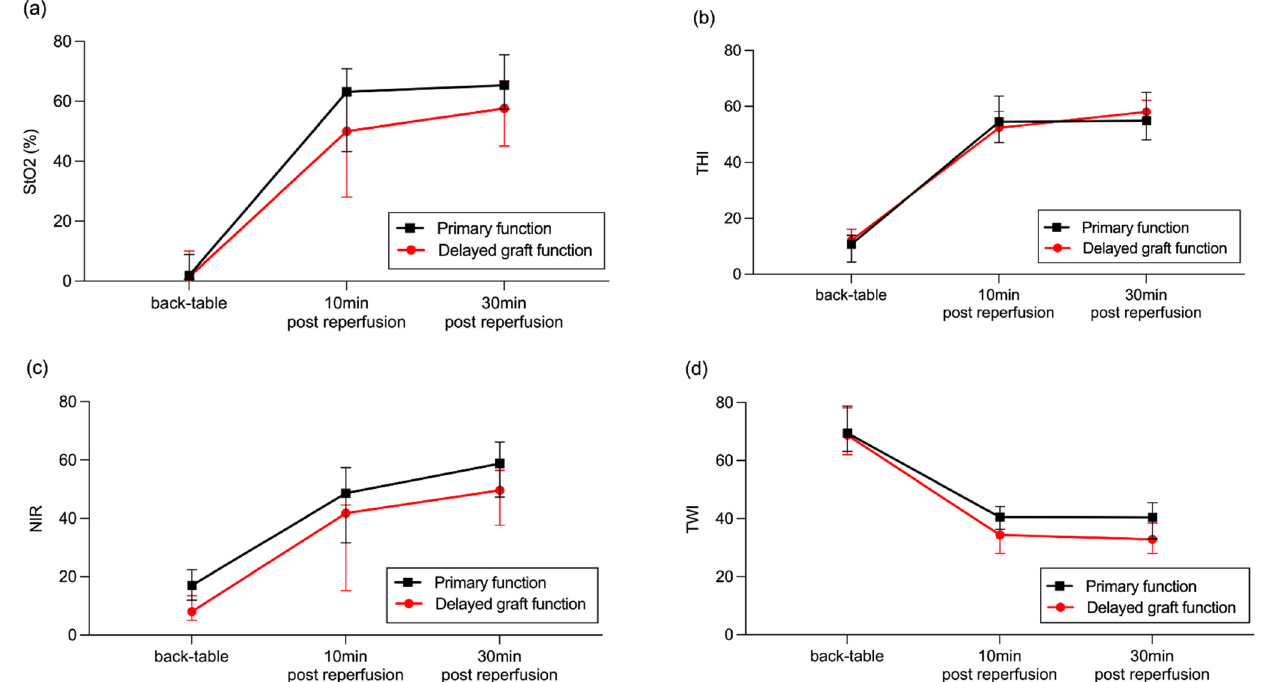
Figure 1. HSI assessment according to initial graft function: ( a ) StO 2 , ( b ) THI, ( c ) NIR, ( d ) TWI. Data are presented as median (interquartile range). Table 4. HSI parameters stratified according to organ preservation method.